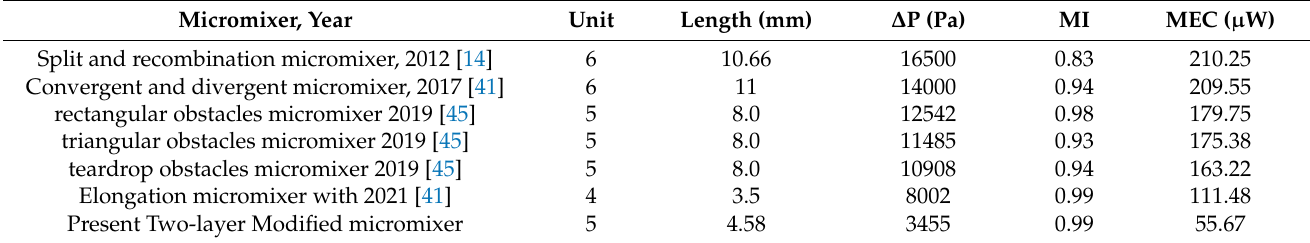
Table 6. Comparison of the pressure losses, mixing degree and energy mixing cost with different recent works at fixed Reynolds number (Re =